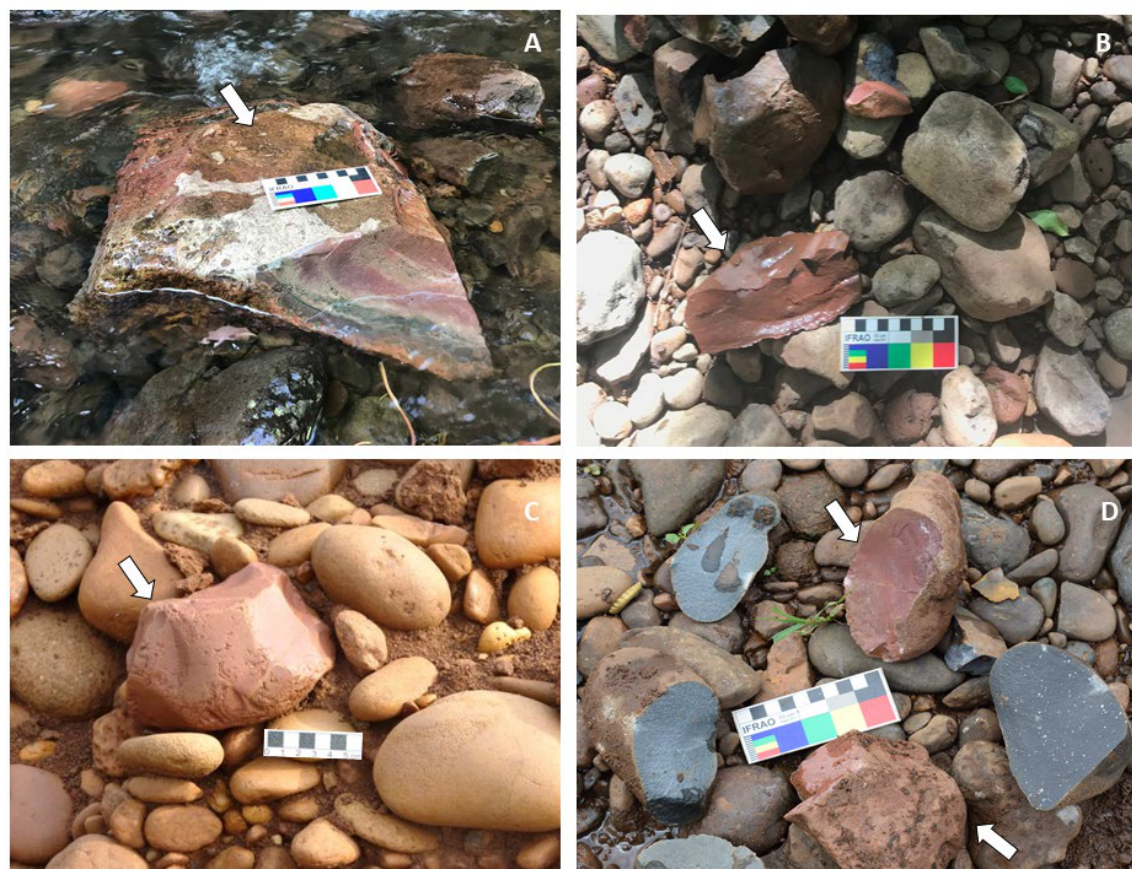
Figure 9. Silicified sandstones marked with white arrows. A: boulder (fractured) emerging in Taquarussú River (Chapecó County). B: pebble fractured during the sampling in Taquarussú River (Cordilheira Alta County). C: pebble in Uruguay River (Palmitos County, Santa Catarina). D: fractured pebbles in Ariranha River (Arvoredo County, Santa